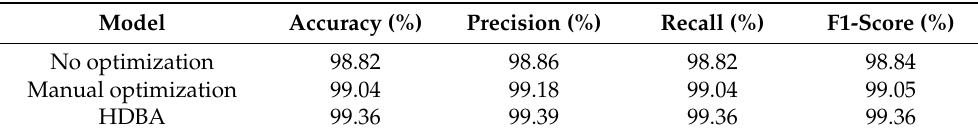
Table 9. Results of the hyperparameter optimization experiment.